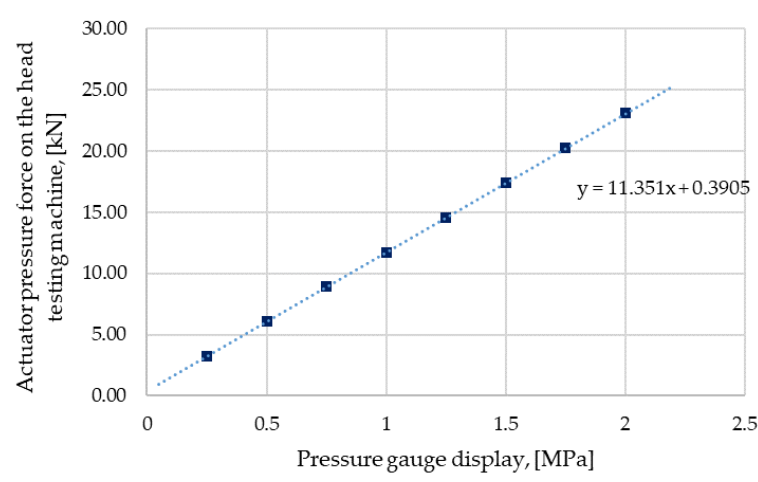
Figure 8. Correlation of pressure exerted by the actuator with the manometer indications.